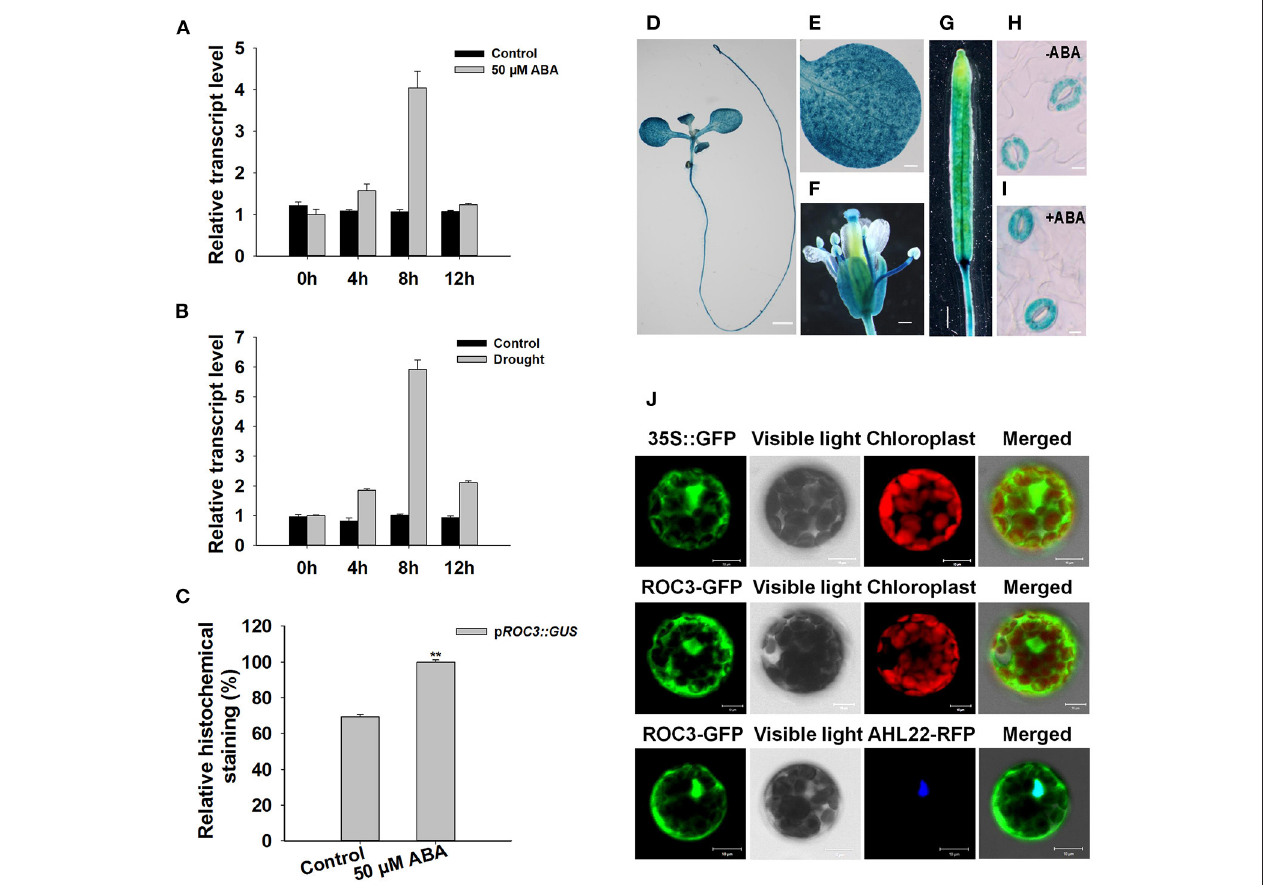
FIGURE 1 | Transcriptional and expression profiling of ROC3 . (A,B) Relative transcript abundances assessed using qRT-PCR in seedlings subjected to (A) ABA treatment, (B) drought stress. (C) Relative GUS activity of p ROC3::GUS in guard cells. Error bars represent the SE ( n = 30), **: means differed significantly from control ( P < 0.01). The experiments were repeated three times with similar results. (D–I) GUS staining reveals the tissue expression of p ROC3::GUS transgene in (D) the whole seedling (bar: 1.5mm), (E) the leaf (bar: 0.3mm), (F) the flower (bar: 0.3mm), (G) the silique (bar: 1mm) and (H,I) guard cells in plants (H) not exposed to ABA (bar: 10 µ m), (I) exposed to 50 µ M ABA (bar: 10 µ m). (J) The topological expression of p 35S::GFP , p 35S::ROC3-GFP , and p 35S::AHL22-RFP in protoplasts (bar: 10 µ